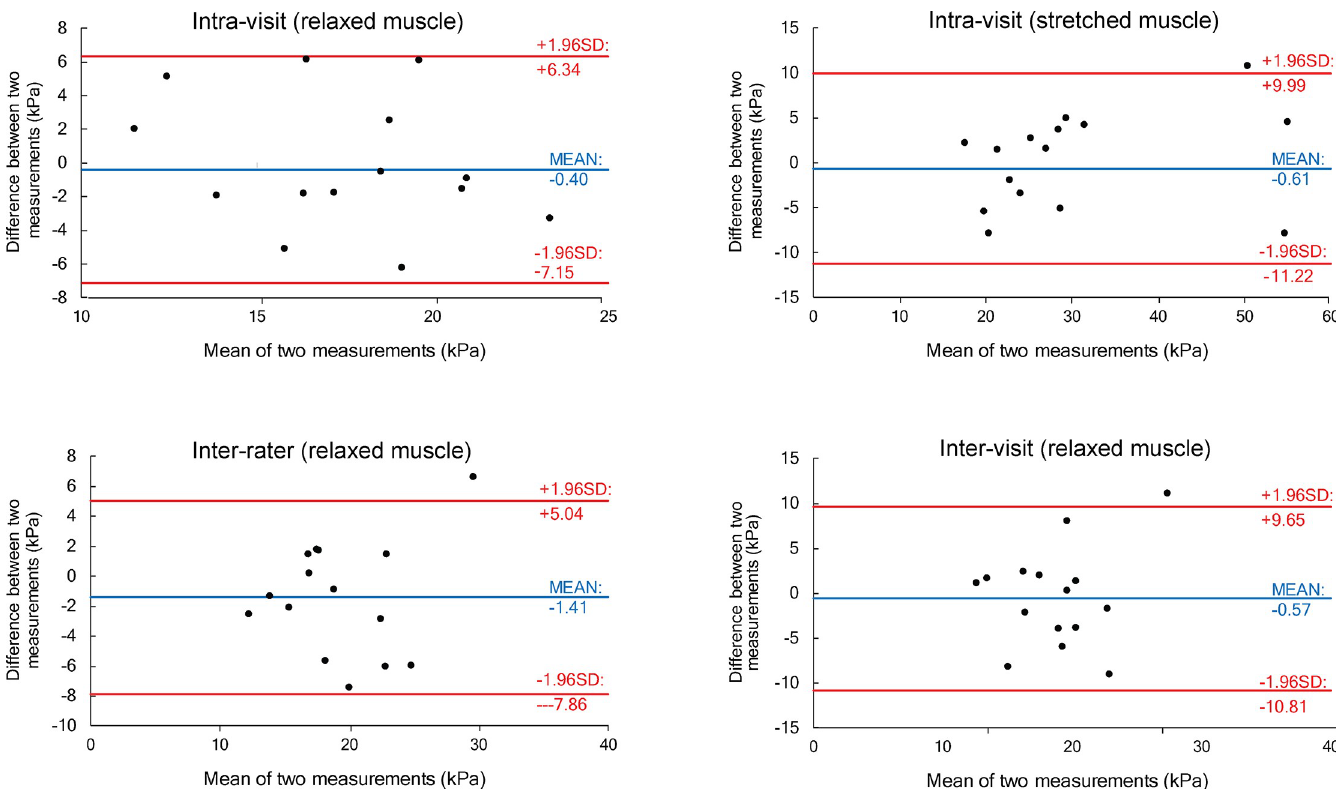
Fig 6. Bland-Altman plots of measurements conducted by human examiners. Horizontal lines indicate the mean difference between measurements (blue) and 95% confidence intervals (red).